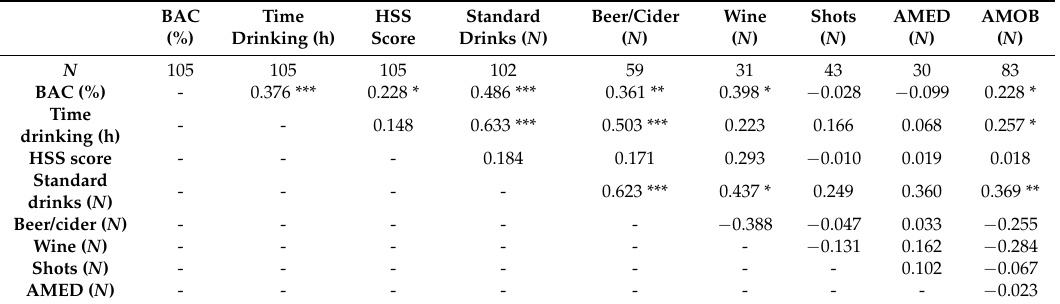
Table 3. Correlations between previous night’s BAC, hangover severity, and drinking